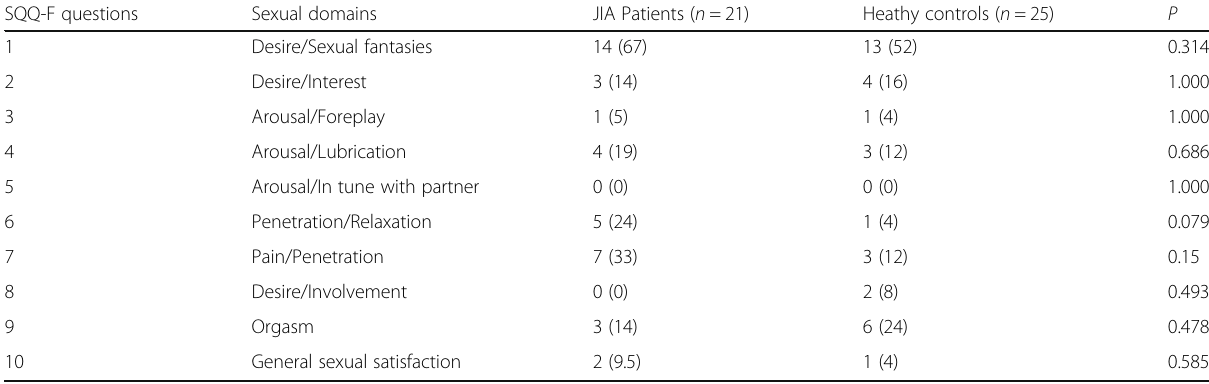
Table 2 Sexual dysfunction according to the 10 questions of Sexual Quotient Questionnaire for Females (SQQ-F) tool in Juvenile Idiopathic Arthritis (JIA) patients and healthy